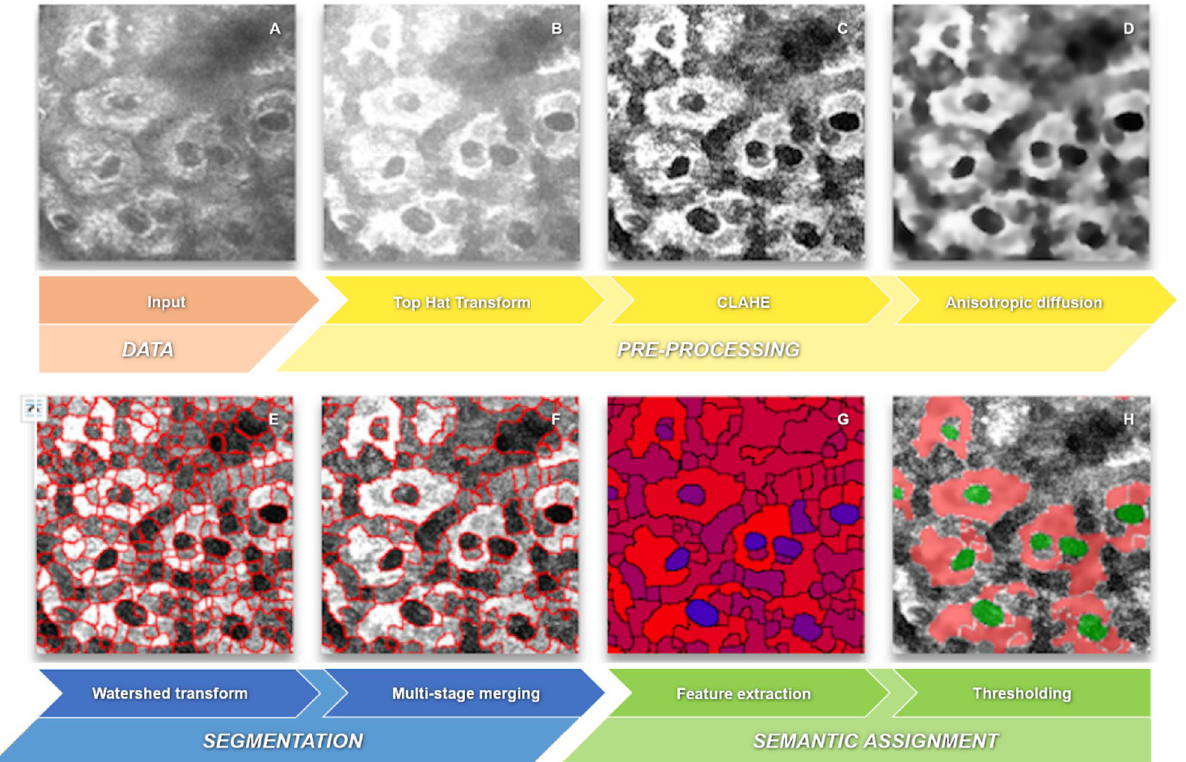
Figure 2. Processing pipeline. Example multiphoton input image from slice 30 ( A ) for illustrating the automatic segmentation of skin cells ( H , cytoplasm (red), nuclei (green)) in subsequent steps: plateauing by Top Hat transform ( B ), contrast enhancement by CLAHE ( C ), edge preserving filtering by anisotropic diffusion ( D ), segmentation (boundaries are red) by Watershed transform ( E ), fusion of over-segmented regions to semantic regions (boundaries are red) by multi-stage merging ( F ), feature extraction using the vector 2-norm ( G ) of the extracted suitable features with respect to model features (minimum vector range (blue) corresponds to greatest similarity to the nucleus model) and subsequent final thresholding ( H